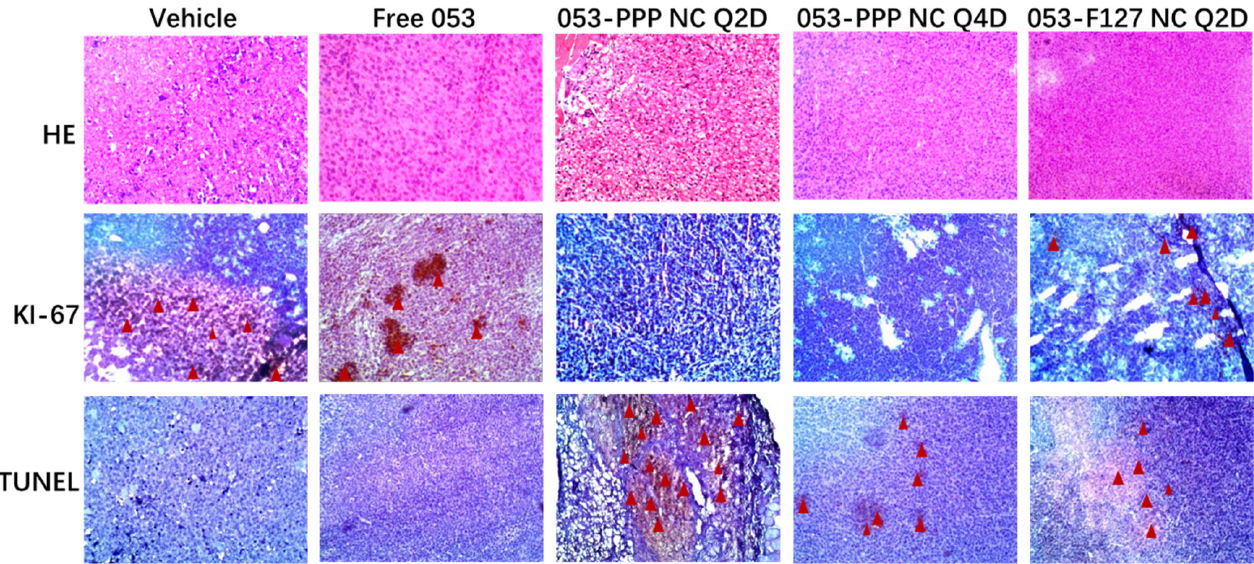
Figure 8. Representative micrographs of HE, Ki-67, and TUNEL staining assays of tumor tissues after treatment with free 053 formulations (PO), 053-F127 NCs and 053-PPP NC micelles (IV) at 40 mg kg − 1 daily compared to the vehicle group.